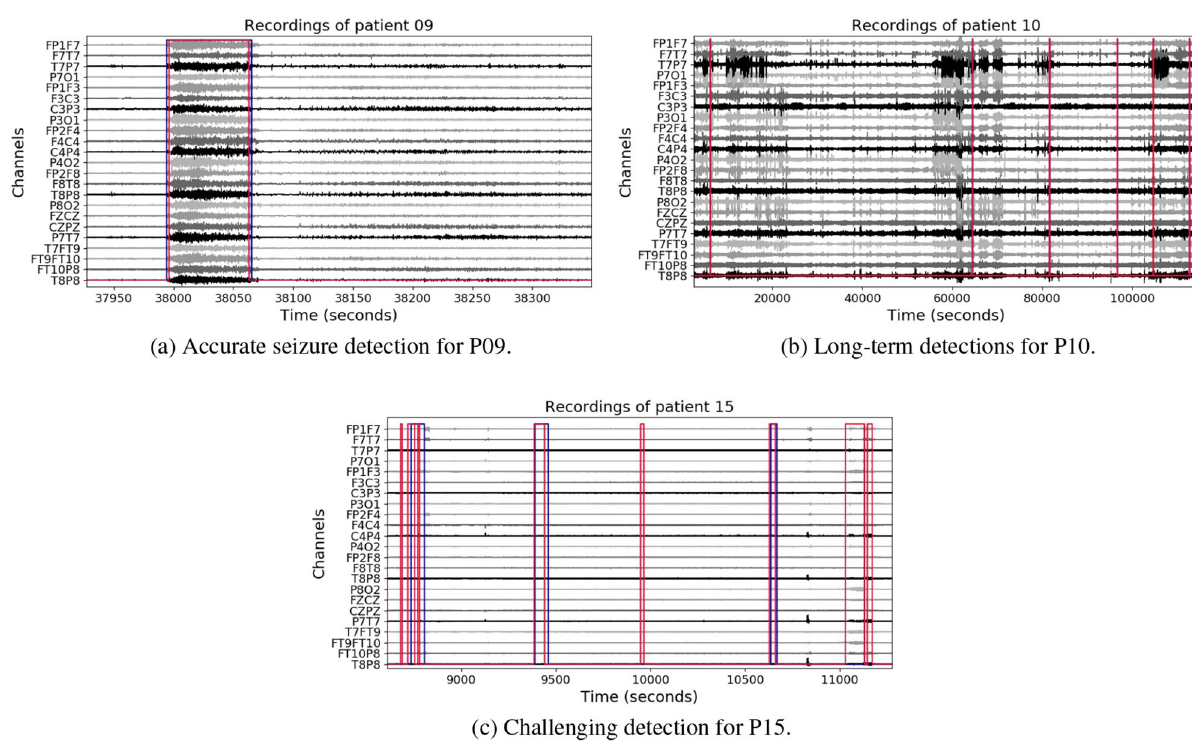
Figure 3. Qualitative results for the best LOO model (base FCN + DO). Annotations (blue) and predictions (red) are plotted over the signals. The bipolar configuration of electrodes is shown in the